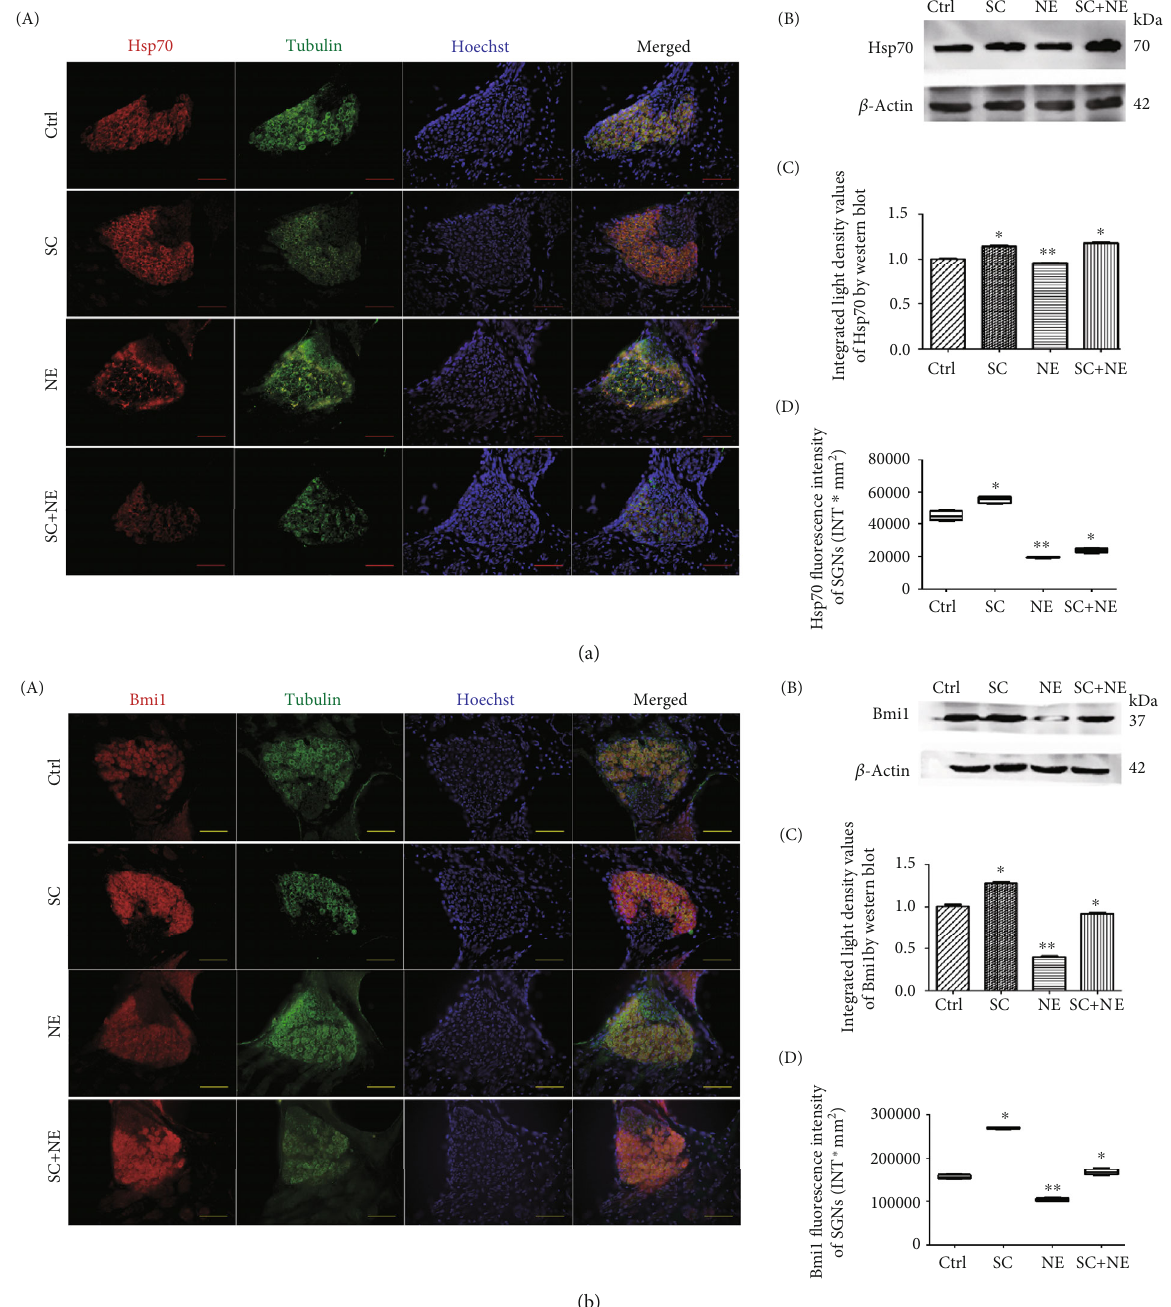
Figure 5: Hsp70 and Bmi1 protein expressions of SGNs after sound conditioning and acute noise exposure. Distributions and expressions of Hsp70 (a) and Bmi1 (b) protein were detected with the immune- fl uorescence assay in the Ctrl and SC groups as well as the NE and SC+NE groups (A), while the quantity of these protein expressions was analyzed by fl uorescence intensity (D). Hsp70/Bmi1 (red) and tubulin (green) as SGN marker were, respectively, labeled with fl uorescent secondary antibody, and nuclei (blue) were labeled with Hoechst. Scale bars represent 100 μ m. Protein expressions of these were also assessed with western blot (B), while the quantity of these protein expressions was analyzed by integrated light density (C). β -Actin protein was available as an endogenous control. Furthermore, values are means ± SD ( n = 12 animals/group). ∗ P < 0 : 05 vs. control group; ∗∗ P < 0 : 05 vs. control group. Statistical analysis of the results presented in (C) was performed with one-way ANOVA (Hsp70: F = 126 : 5 , P < 0 : 0001 ; Bmi1: F = 478 : 8 , P < 0 : 0001 ), followed by Newman-Keuls ’ post hoc test ( ∗ P < 0 : 05 , ∗∗ P < 0 : 05 ; n = 12 animals/group). Statistical analysis of the results presented in (D) was performed with one-way ANOVA (Hsp70: F = 303 : 4 , P < 0 : 0001 ; Bmi1: F = 940 : 7 , P < 0 : 0001 ), followed by Newman-Keuls ’ post hoc test ( ∗ P < 0 : 05 , ∗∗ P < 0 : 05 ; n = 6 pictures from 3 animals/group). Furthermore, values are means ± SD